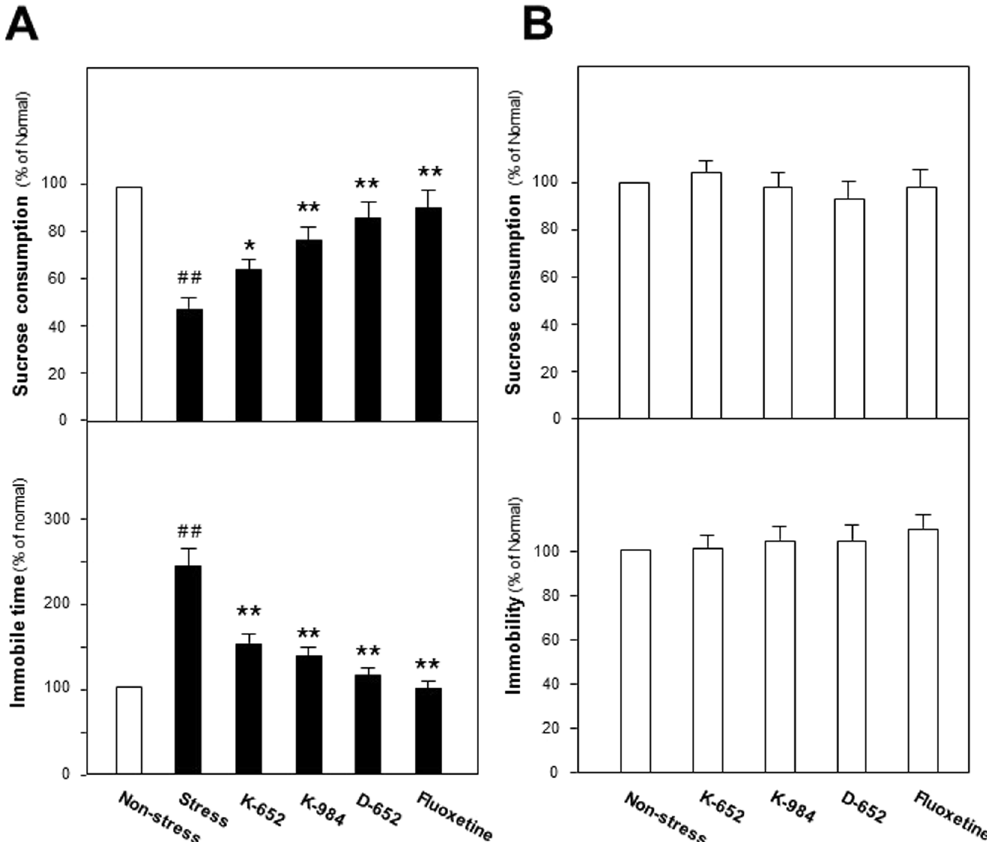
Figure 1. Effect of KXS series formulae treatment on the behaviors of CUMS-treated mice. ( A ) After four weeks of CUMS treatment, all groups of mice were employed for behavior evaluation tests, including the sucrose preference test, forced swimming test. Fluoxetine at daily dosage of 4 mg/kg was set as the positive control. KXS series treatment was set for three groups, K-652, K-984, D-652, all at 10 g/kg. ( B ) Non-stressed mice were treated with fluoxetine and KXS. The period and dosage of treatment were same to that of CUMS treated groups. Afterwards, same behavior evaluation tests were applied. Values are expressed in the percentage of non-stressed group as Mean ± SEM (n = 8). Comparisons between groups were carried out by a one-way ANOVA followed by a post-hoc Bonferroni test. # p < 0.05, ## p < 0.01 (compared with non-stressed group); * p < 0.05, ** p < 0.01 (compared with stressed